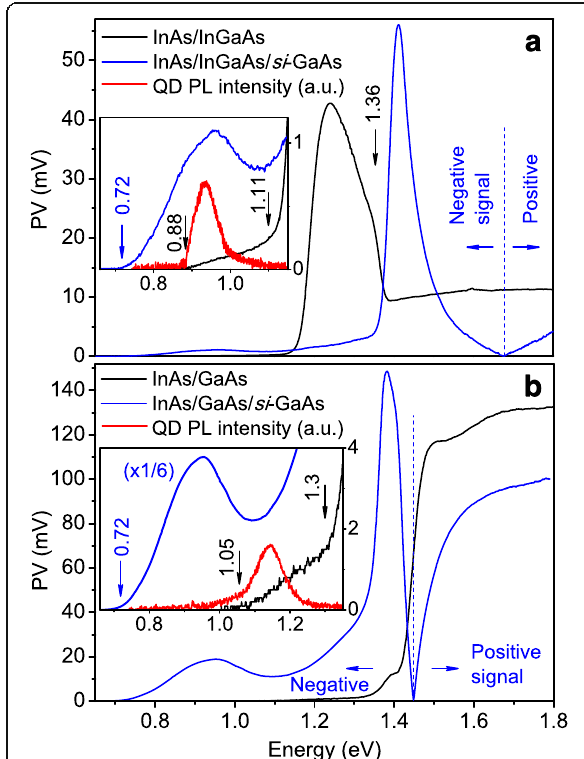
Fig. 2 (Color online) room temperature PV spectra of the a metamorphic InAs/In 0.15 Ga 0.85 As and b InAs/GaAs QD structures; PV was measured contacted to only MBE layers [45] (black curves) and through the semi-insulating si -GaAs substrate (blue). The PV spectra measured through the si -GaAs substrate are inverted by sign of voltage below 1.68 and 1.44 eV respectively for a and b . Low-energy parts of the curves are given in the insets; the QD PL bands measured before [45] for both the structures are presented for the QD ground state energy positioning